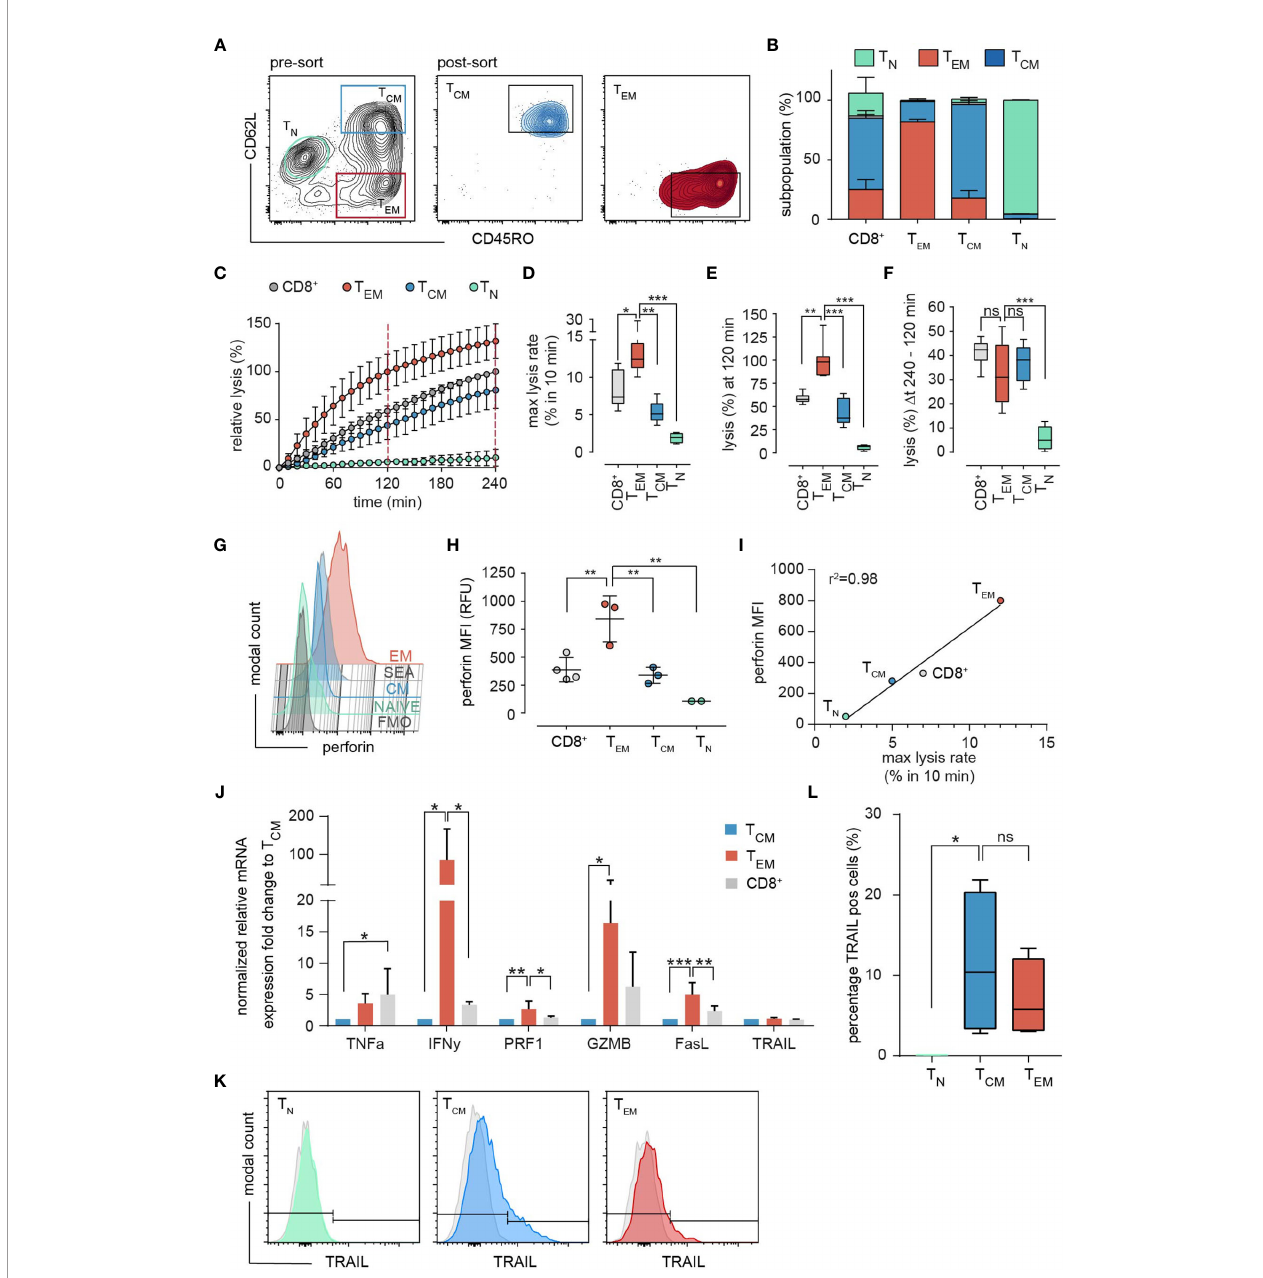
FIGURE 3 | Subset-speci fi c cytotoxicity of sorted T EM and T CM . (A) Representative example of the sorting strategy. After exclusion of doublets and dead cells by light scatter parameters, the SEA-CTL (CD8 + ) population was separated and sorted into T EM and T CM cells by the surface marker CD62L and CD45RO. 24h after sorting cells were re-analyzed by a staining of CD45RA and CCR7. The subset composition of sorted samples is shown as stacked bar graphs (B) , (T EM , red; T CM , blue; T N , green). (C) Cytotoxicity of sorted T EM , T CM , T N and of the unsorted SEA-CTL population (CD8 + ) was analyzed by a calcein-based real-time killing assay. (D-F) To quantify the killing ef fi ciency, the maximal lysis rate (maximal target cell lysis within a 10 min interval), the target lysis between 0 - 120 min (E) and 120 min - 240 min (F) were analyzed (number of donors, SEA-CTL (CD8 + ) n=9, T EM n=8, T CM n=7, T N n=4 donors). Box and whisker plots in D-F show min, max, median, and 25-75% interquartile range. Statistical analysis was done by a one-way ANOVA. (G) Perforin expression in sorted T EM , T CM , T N and in the unsorted SEA-CTL (CD8 + ) population of a representative donor analyzed by fl ow cytometry. (H) Quanti fi cation of intracellular perforin by MFI. SEA-CTL (CD8 + ) n=4, T EM n=3, T CM n=3, T N n=2 donors. Scatter plots show mean ± SD, statistical analysis was done by a one-way ANOVA. (I) MFI of intracellular perforin (H) plotted against maximal lysis rates (D) . (J) Expression of various effector molecules, TNFa, IFNy, PRF1, GZMB, FASL and TRAIL genes was analyzed on mRNA level by RT-qPCR, 48h after sorting. Relative mRNA expression is shown as fold change normalized to the T CM population. T EM and T CM n=4, SEA-CTL (CD8 + ) n=2 donors. Bar graphs show means ± SD. (K) Expression of TRAIL in T N, T CM and T EM subsets analyzed by fl ow cytometry. (L) Percentage of TRAIL positive cells was quanti fi ed as a box and whisker plot. N = 4 donors. Statistical analysis was done by a Kruskal-Wallis-Test. *p<0.05; **p<0.01; ***p<0.001; ns, no signi fi cant